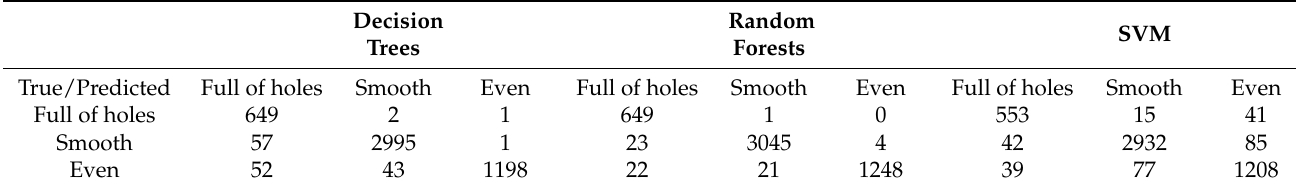
Table 3. Confusion matrix for road surface conditions classification.